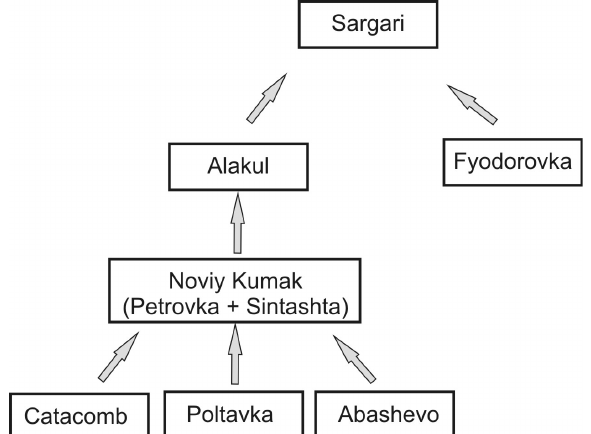
Figure 10: Sintashta culture: 1, 11 – Arkaim settlement; 2–8, 10–15 – Sintashta cemetery; 9 – Bolshekaragansky cemetery (1, 11 – after Zdanovich, 1997; 2–8, 10–15 – after Gening, Zdanovich, & Gening, 1992; 9 – after Botalov, Grigoriev, & Zdanovich, 1996).